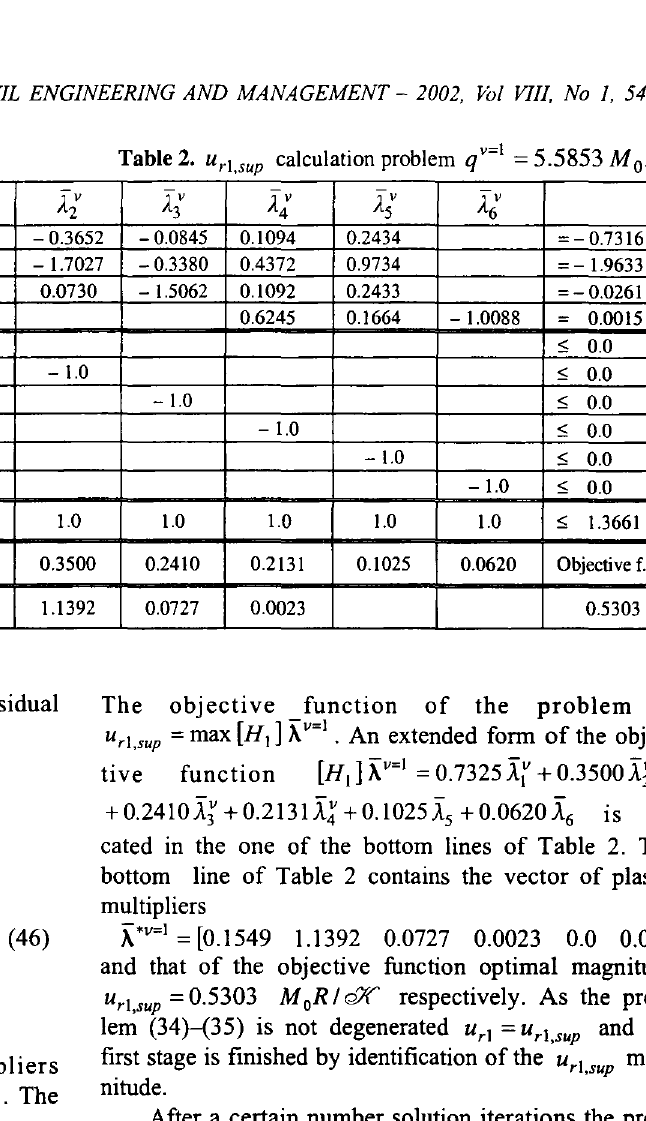
Table 1. Structure of the problem